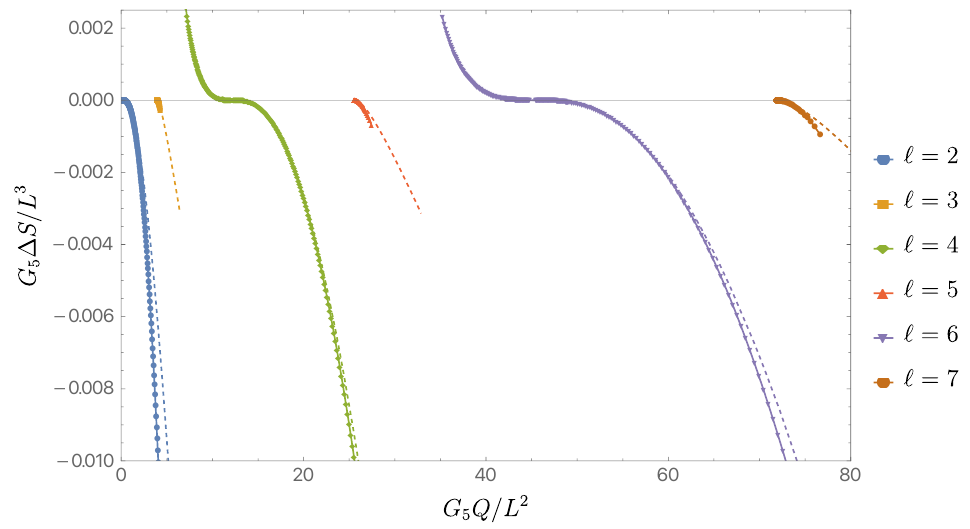
Figure 13 . ∆ S as a function of Q for the new IR geometries near their onset, for ‘ = 2 , . . . , 7 . The several dashed lines give the perturbative expansions detailed in 3.1 and above, while the several coloured symbols how our exact numerical data. The several values of ‘ are distinguished by colour, and are labelled on the